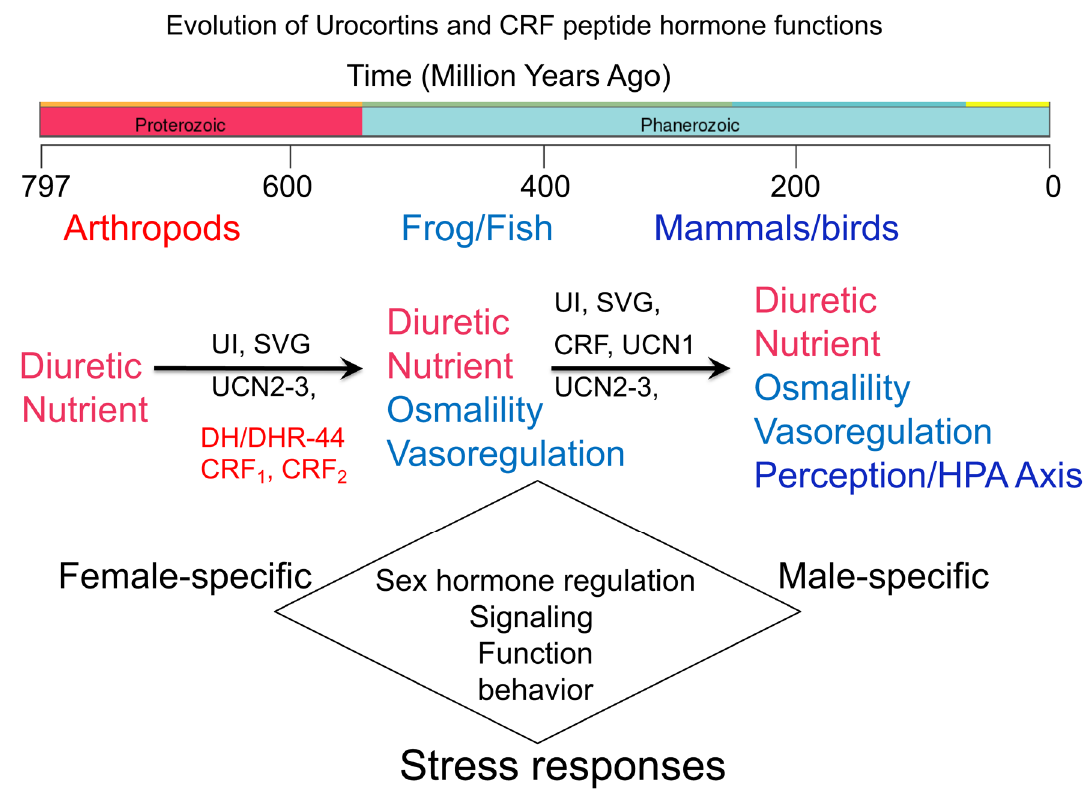
Figure 7. A summary schema showing the evolution of CRF and urocortins hormones and their functions. Diuretic hormones (DH44) and DH44 receptors in the fruit flies probably served as prototypes for urocortin 3 and 2, and CRF receptors, respectively, which first appeared in Actinoptergyii (fish) and Sarcoptergyii after a genome-wide duplication event nearly 400 million years ago. Distinct CRF, urotensin I (UI), urocortins, and sauvagine peptides first seemed to have appeared nearly 500 million years ago. The innervation of hypothalamic cells by CRF family members occurred in class Actinoptergyii along with appearance of urocortin-like peptides. The release of CRF into the portal circulation appeared in Sarcoptergyii, whereas UI-like and sauvagine peptides transitioned to being expressed in the skin in the amphibians. The innervation and descending of CRF fibers in the spinal cord seemed to have occurred nearly 290 million years ago [2]. As the peptides